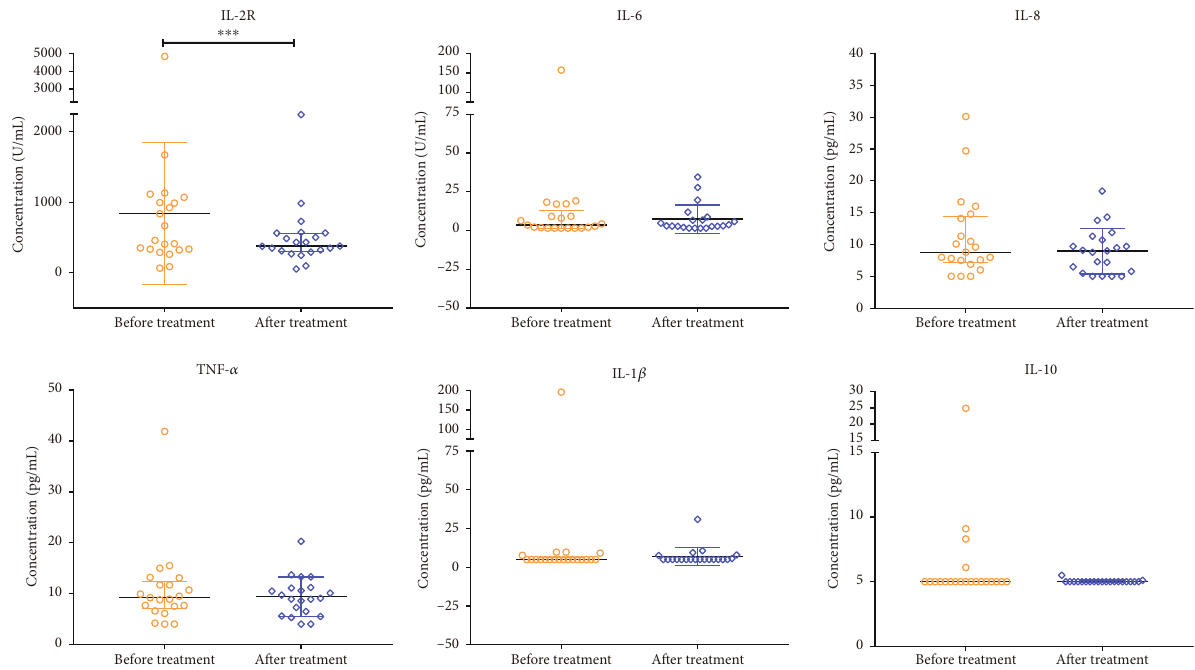
Figure 2: Comparison of cytokine levels in COVID-19 patients before and after treatment. P values were tested using Wilcoxon signed-rank test. “ ∗∗∗ ” was indicated as P value <